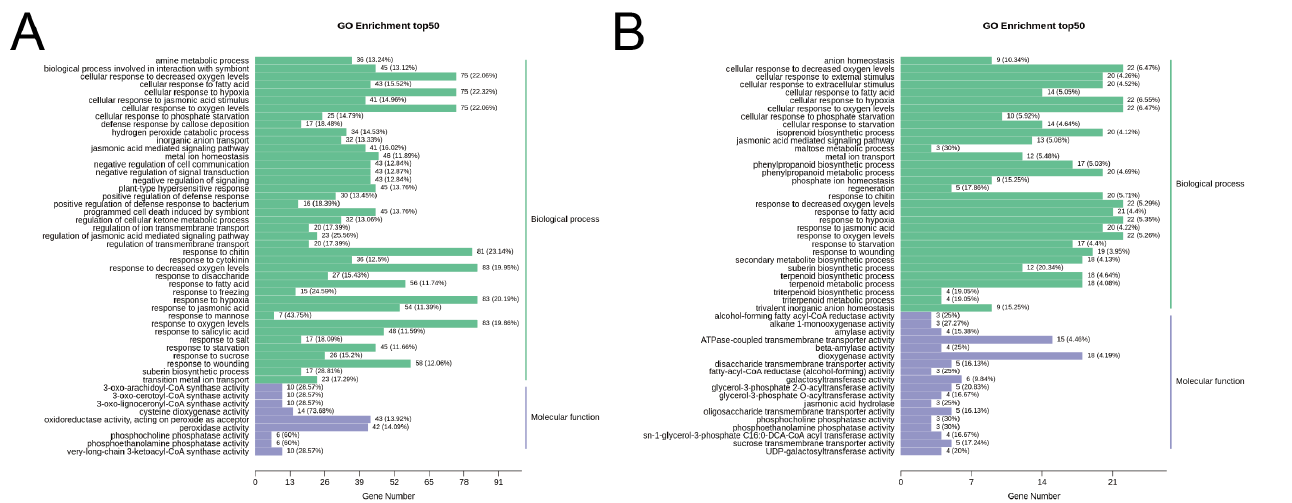
Figure 8. GO enrichment of induced DEGs. ( A ) GO enrichment of DEGs between EV vs. OE. ( B ) GO enrichment of DEGs between EV vs.